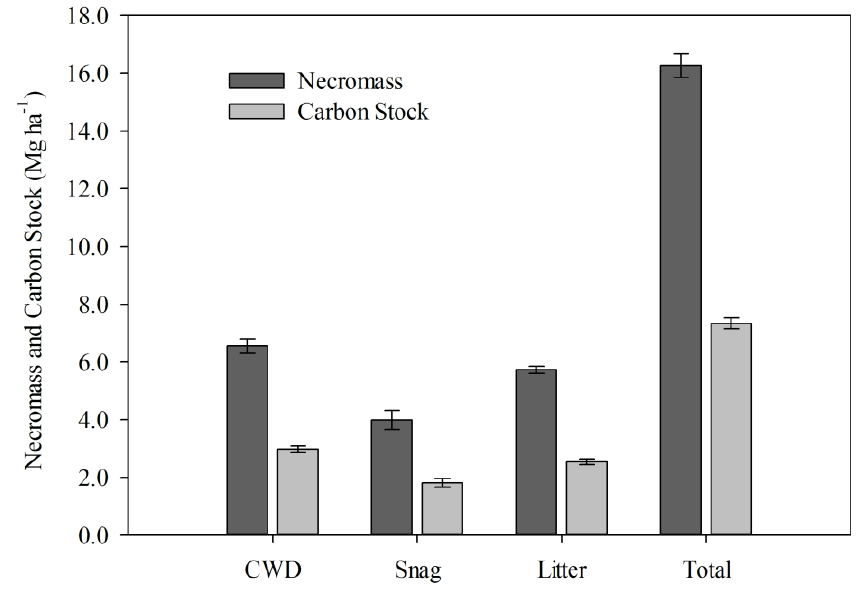
Figure 3. Necromass and carbon stock (Mg ha − 1 ) of the CWD, snags, litter, and total of the secondary Atlantic Forest fragment.